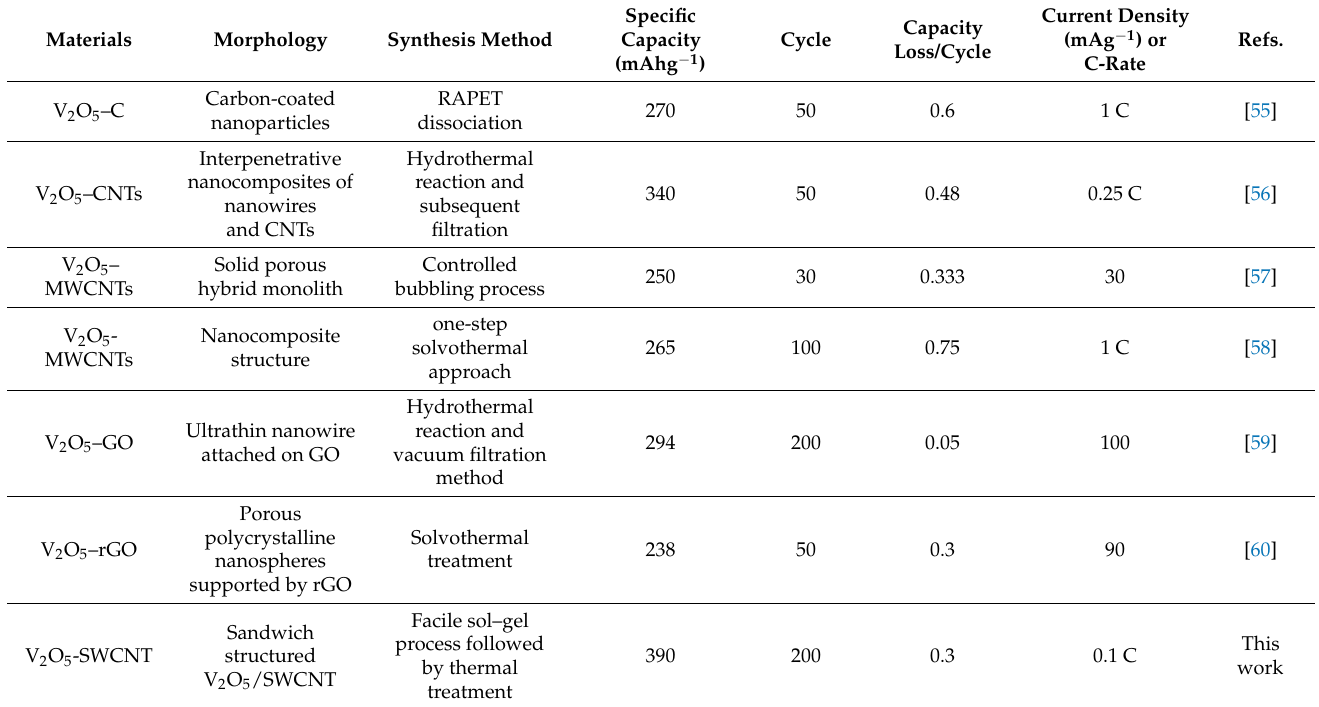
Table 1. Comparison of our work and recently published works on V 2 O 5 /Carbon composites for lithium-ion